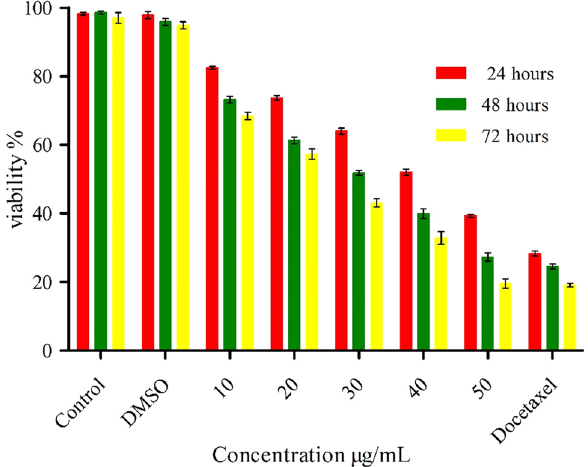
Figure 1: E ff ect of Equisetum arvense extract on the viability of LNCaP cells. The viability percentage was measured using MTT assay. LNCaP cells were treated with di ff erent concentrations of the extract for 24, 48, and 72 h.